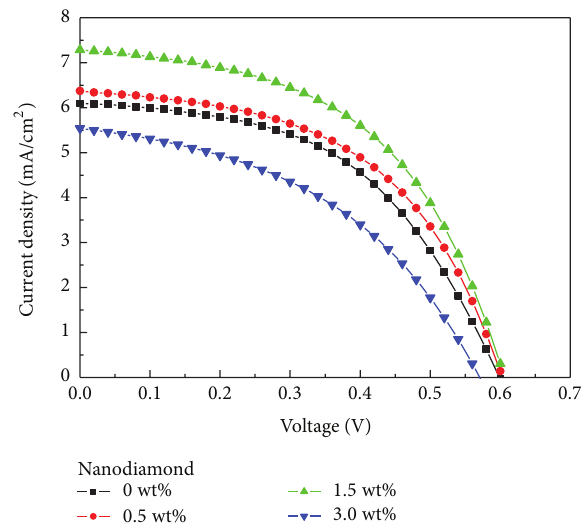
Figure 5: Current density-voltage characteristics of hybrid OPVDs doped with nanodiamond at various concentrations, under AM1.5G at 100 mW ⋅ cm −2 illumination.